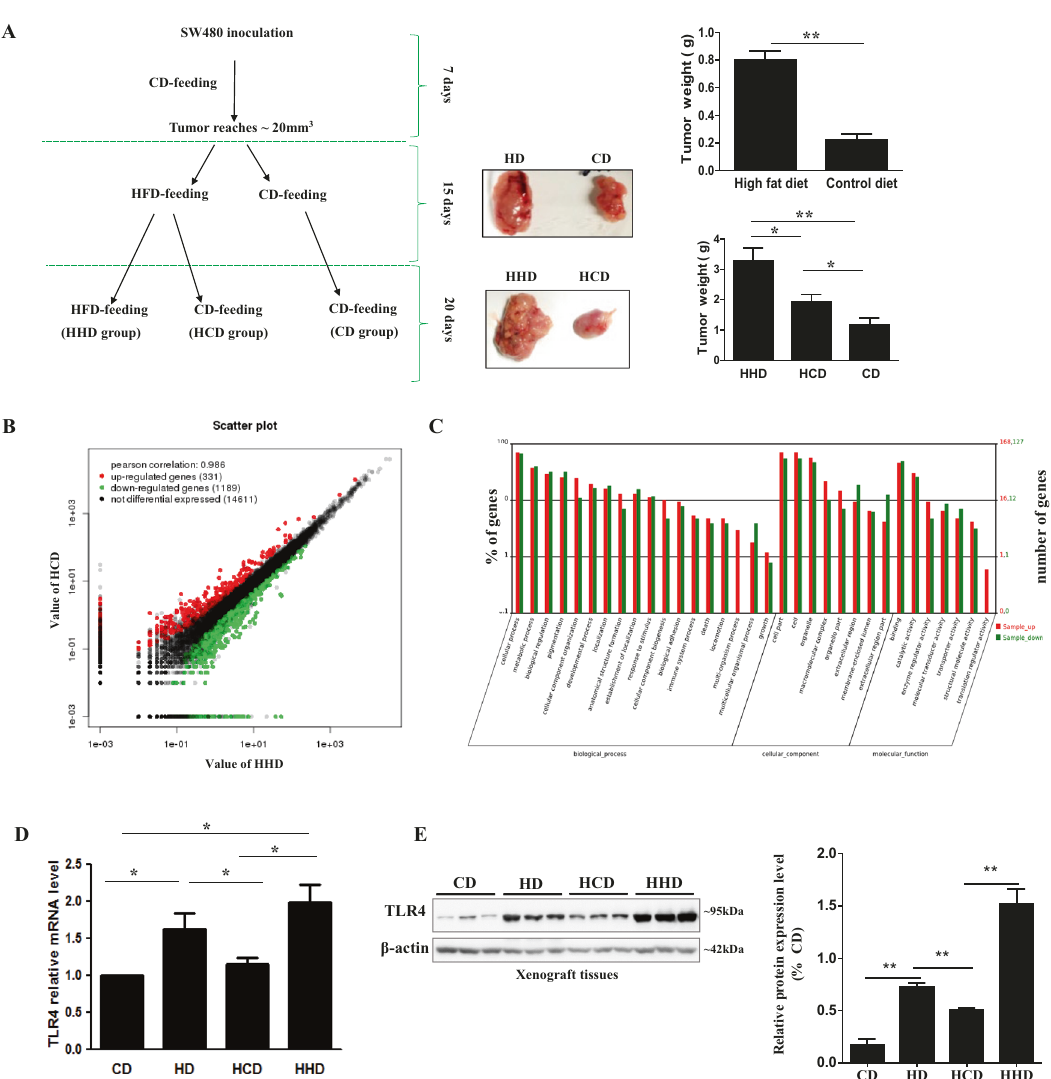
Fig. 1 High-fat diet (HFD) feeding increases TLR4 expression in CRC. A Schematic diagram showing the dietary intervention and the tumor size and tumor weights of the xenograft mouse models. B RNA sequencing showing the number of upregulated and downregulated genes in the HCD and HHD tumor samples. C GO analysis for the biological functions of the genes that show signi fi cant changes between HCD and HHD tumor samples. D TLR4 mRNA levels and E the protein levels and quanti fi cation in the tumor tissues. CD, matched control diet feeding; HD, high-fat diet feeding; HHD, HFD feeding persisted for 35 days; HCD, HFD feeding for 15 days followed by CD feeding for 20 days. Data are shown as means ± SEM, n = 4 – 8 mice in each group. * p < 0.05, ** p < 0.01 as indicated. (Fig. 4I). These data evidently suggest that palmitic acid increases good. The KD of the dissociation-equilibrium constant of palmitic CRC cell proliferation in a TLR4-dependent manner. acid binding to TLR4 protein was 35.56 M, which was obtained by computer fi tting. The lower the KD value, the better the binding of HFD or palmitic acid-rich diet (PAD) increases CRC growth in a the sample to the protein. The KD value suggests that there is less TLR4-dependent manner likely to have a binding between palmitic acid and TLR4 protein, Next, we examined whether TLR4 mediated the HFD-associated which agrees with other studies [5, 6, 26]. The enhanced CRC growth in vivo. We subcutaneously inoculated wild-type phosphorylation of NF κ B in CRC cells after palmitic acid treatment HCT116 cells or TLR4-knockout HCT116 cells (HCT116 TLR4_KO ) into (Fig. 4D, E) suggests that the activation of the TLR4 signaling pathway is, at least in part, due to the enhanced TLR4, MyD88, and the nude mice. When the tumor volume reached ~80 mm 3 in TIRAP expressions in the cancer cells but not a direct binding of volume, we randomly divided them into HFD group and CD palmitic acid to the TLR4 protein. group. The HFD (D12492, Research Diets) was formulated to have Our data also showed that palmitic acid increased CRC cell 49.9 g of palmitic acid in 254.5 g of the total fatty acids, in which proliferation that was abolished in the presence of TLR4 inhibitor palmitic acid accounts for 19.6% of the total fatty acids. The mice C34 (Fig. 4F, G). To further suggest that TLR4 mediated the in the control group were fed a matched control diet (CD) palmitic acid-increased CRC cell proliferation, we knock out TLR4 (D12450J, Research Diets). Although HFD is commonly used to in the HCT116 cells (TLR4_KO) (Fig. 4H). Data showed that palmitic induce obesity, it cannot clearly demonstrate the effect of palmitic acid failed to increase the proliferation of the TLR4_KO cells acid on CRC growth in the mouse model. Therefore, another batch Cell Death and Disease (2021)